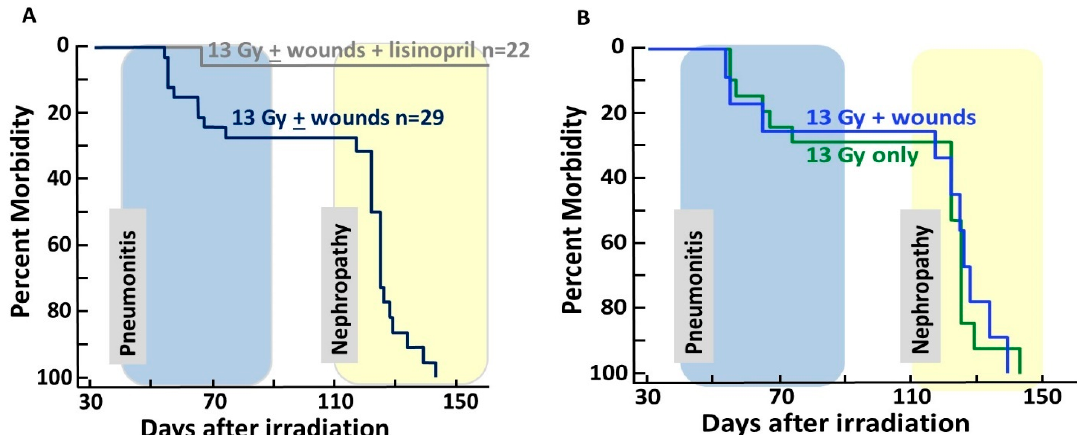
Figure 4. Kaplan–Meier plots depicting morbidity from 31 to 150 days after 13 Gy leg-out PBI. Following acute radiation syndrome (ARS), rats were at risk for morbidity from DEARE. Morbidity accrued secondary to radiation pneumonitis between 42 and 90 days (shaded blue) and radiation nephropathy (shaded yellow) after 110 days following 13 Gy leg-out PBI. ( A ). Irradiated and wounded rats were morbid by 150 days (navy blue line) except those receiving lisinopril (grey line) started at 7 days after radiation and continued. p ≤ 0.0001 between the 13 Gy leg-out PBI with or without wounds vs. 13 Gy leg-out PBI with or without wounds + lisinopril. ( B ). There is no difference in morbidity between irradiated rats with wounds (blue line) vs. irradiated only rats (without wounds, green line) if the rats were not given lisinopril.